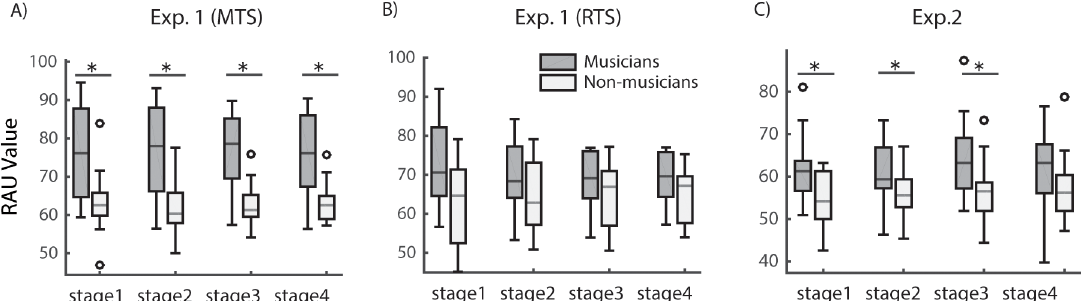
Fig 6. Performance across testing stages. Performance of musicians (gray box) and non-musicians (open box) is plotted for each of the four testing stages. The performance is plotted as the RAU value. Each box represents percentiles of the data. The line within the box indicates the median. Error bars represent the minimums and maximum values. Small circles indicate the outliers. The significant difference between musician and non-musicians groups is indicated by the asteroids above the two boxes for each testing stage. ( A ) MTS condition in Experiment 1. Musicians’ performance is significantly higher than non-musicians at all four testing stages. ( B ) RTS condition in Experiment 1. No significant difference between musicians and non-musicians. ( C ) Experiment 2. Musicians’ performance is significantly higher than non-musicians at stages 1, 2, and 3, but not at stage 4. The significant difference was marked as